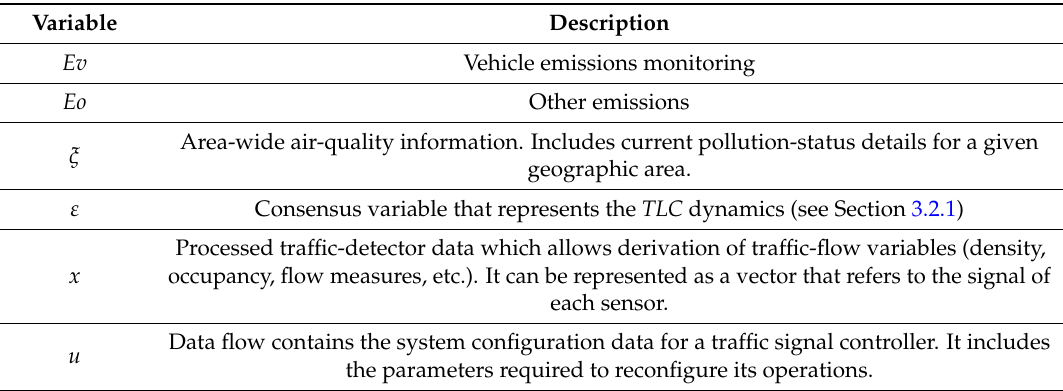
Table 1. Description of data